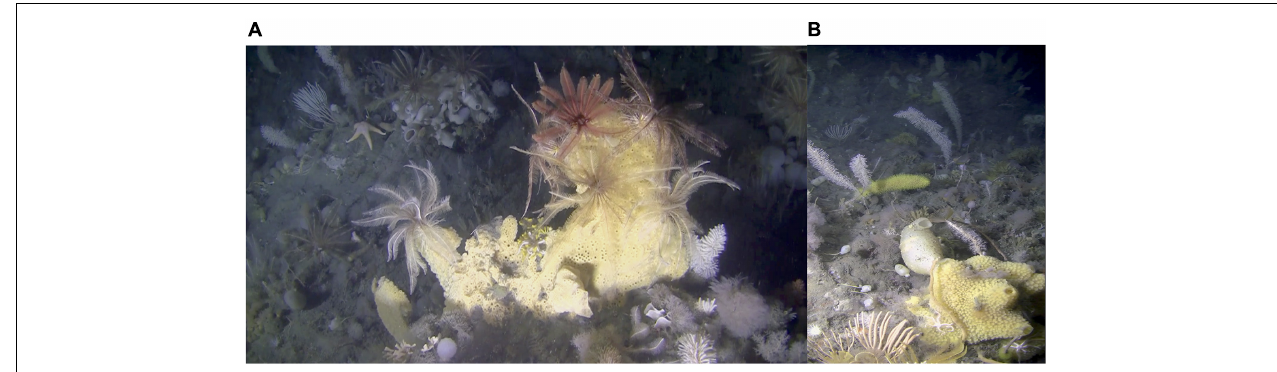
FIGURE 6 | VME at Kinnes Cove, Antarctic Sound (Dive 3). (A) A large hexactinellid Rossella cf. podagrosa cluster in the background and a large yellow Mycale demosponge in the foreground provide habitat for a multitude of organisms, ∼ 260 m. (B) The significantly high abundance of VME indicator taxa is illustrated well here; as the view is directed horizontally along the wall, it is possible to see that the structural complexity is great and that it extends beyond the range of visibility, ∼ 300 m.